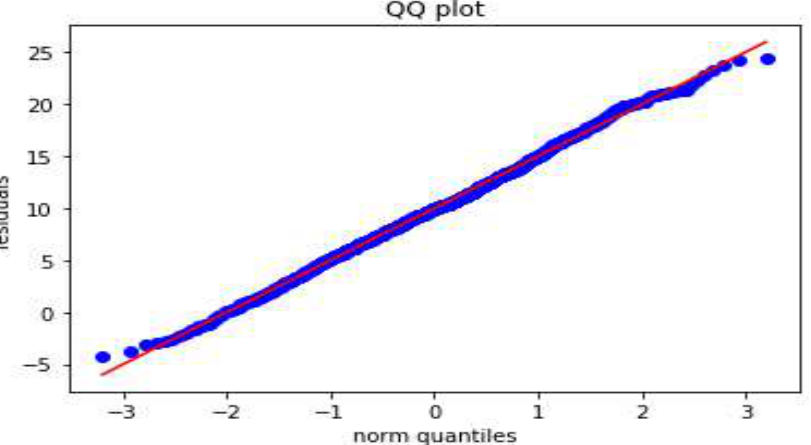
Figure 9. QQ plot showing data variability along normal quantile distribution (red line showing 45 degrees).